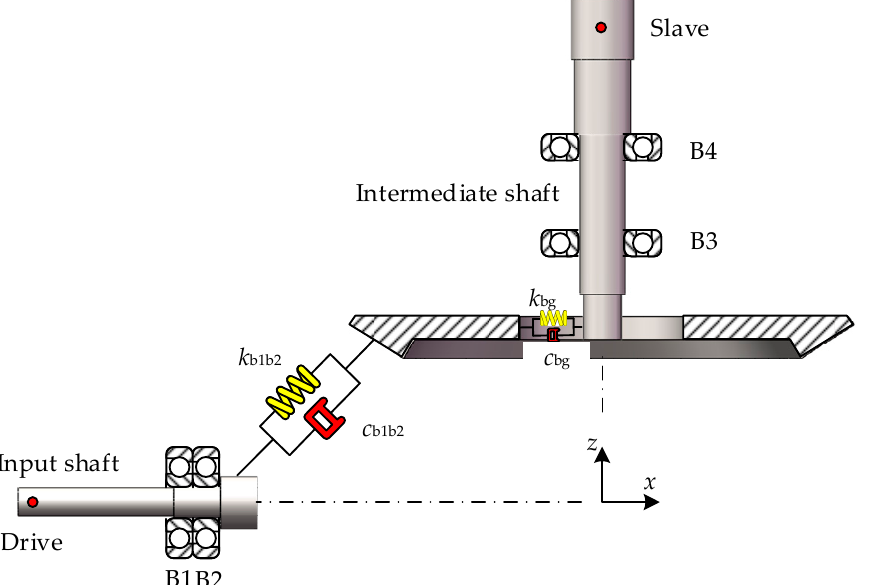
Figure 16. A dynamic model of the coupling SBGP and shafts system. Figure 16. A schematic of the coupling SBGP and shafts